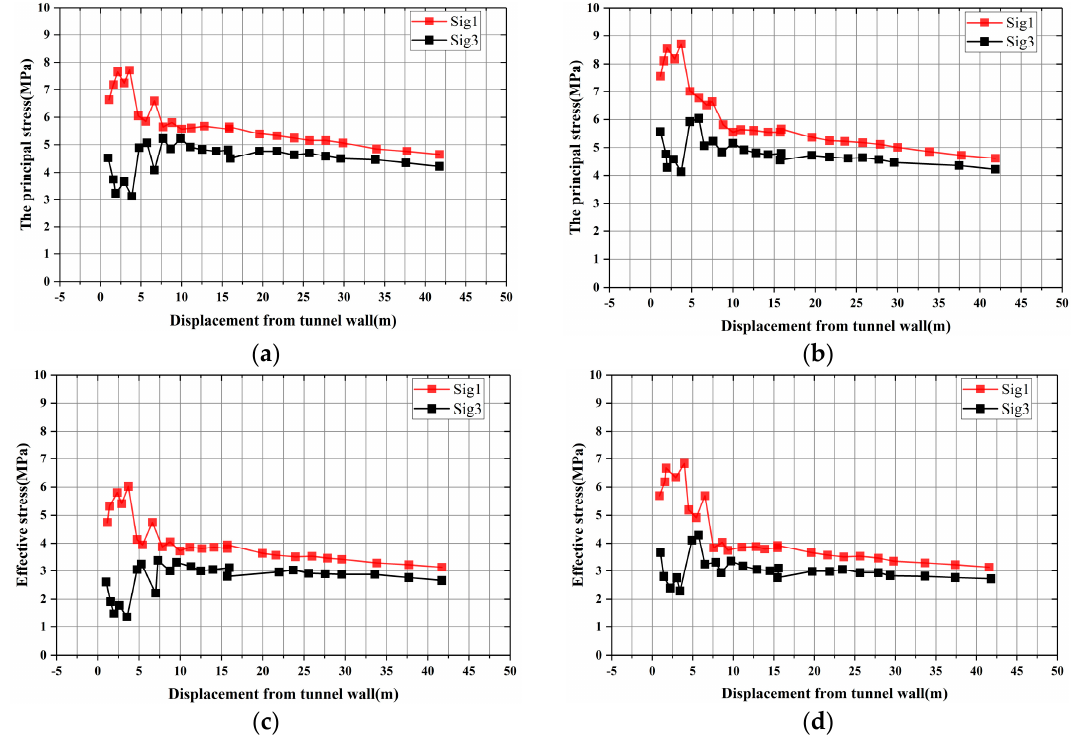
Figure 12. Stress distribution in horizontal line. ( a ) The principal stress in Case 1; ( b ) the effective stress in Case 0; ( c ) the principal stress in Case 1; ( d ) the effective stress in Case 0. (2) The Minor Principal Stress of Supporting Structure.